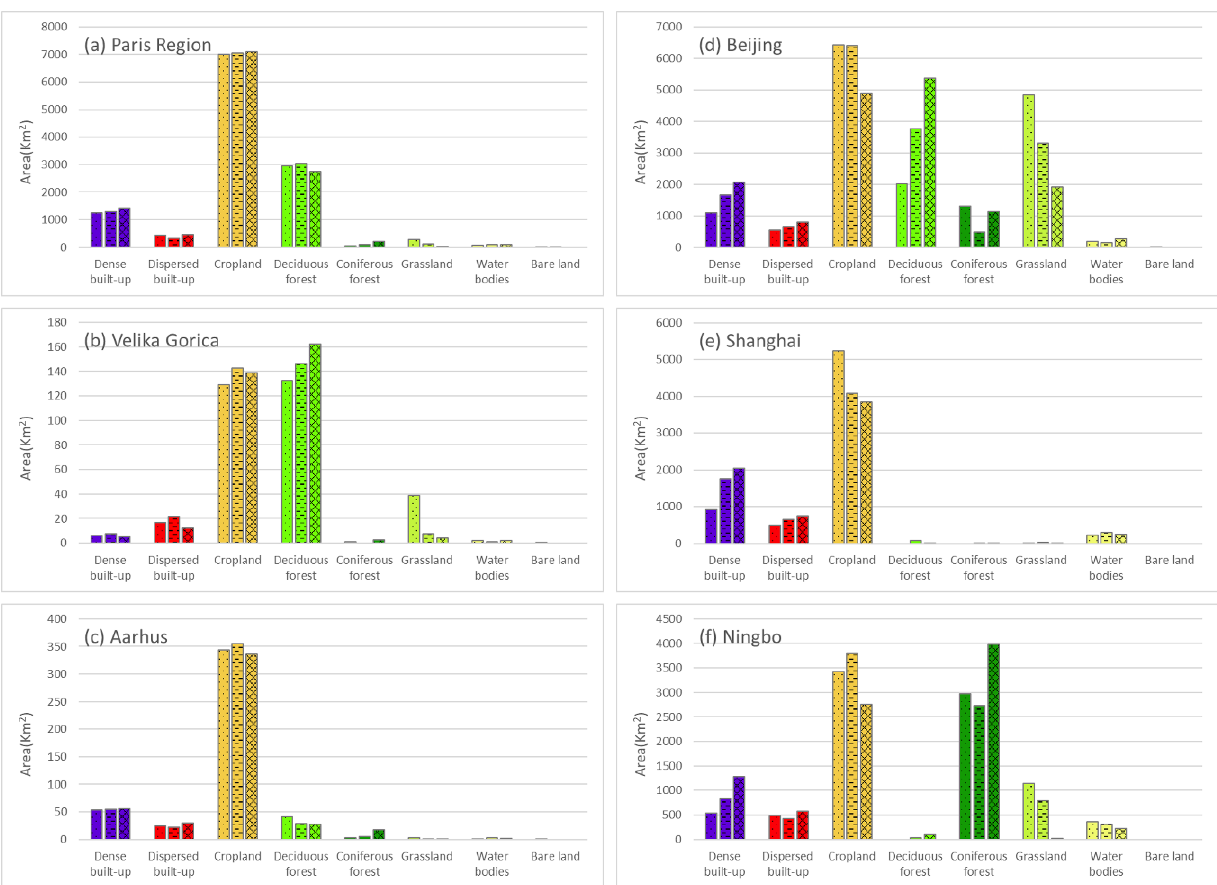
Figure 5. The area statistics of various land cover types in 2000, 2010 and 2020. Table 5. Area statistics of LULC in 2000, 2010 and 2020 in km 2 .